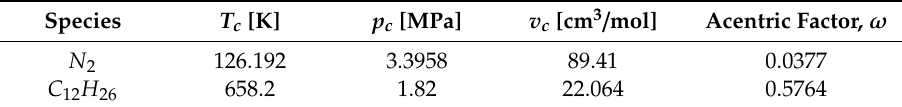
Table 1. In this numerical study, the injection of a single-component mixture, L-N 2 / G-N 2 and a binary (multicomponent) mixture, C 12 H 26 / N 2 are considered. In the case of cryogenic nitrogen into nitrogen, two species with identical properties are considered in the simulation, in order to track the injected species separately from the ambient one. Table 1. Critical condition parameters for pure species